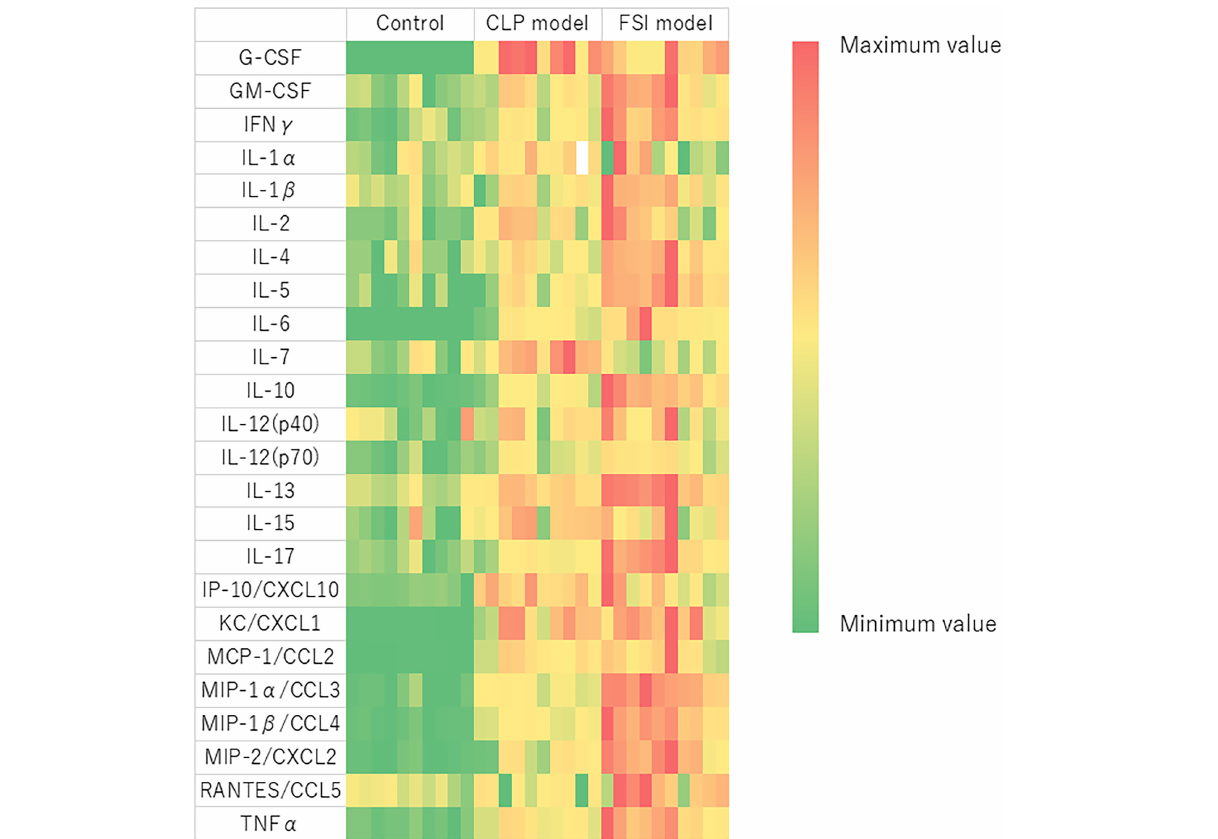
Frontiers in Medicine |